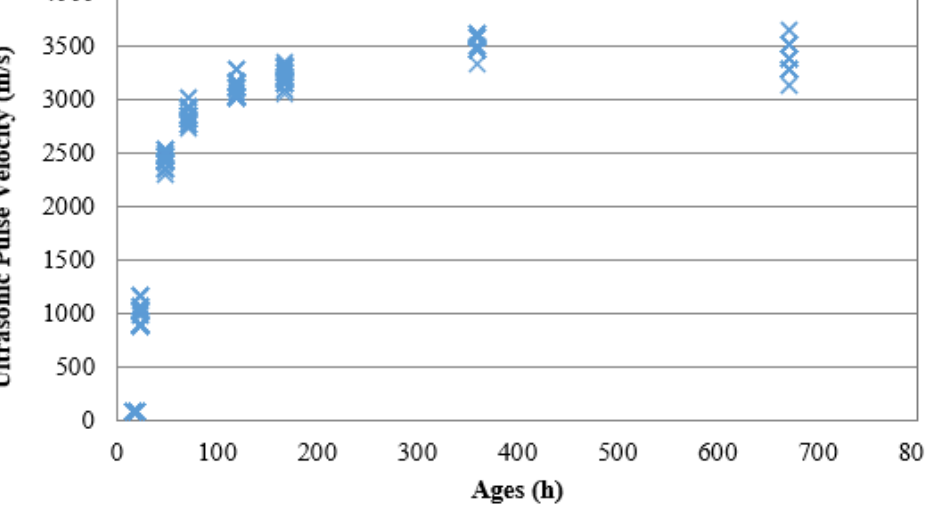
Figure 8. Compressive strength with age (30 MPa).